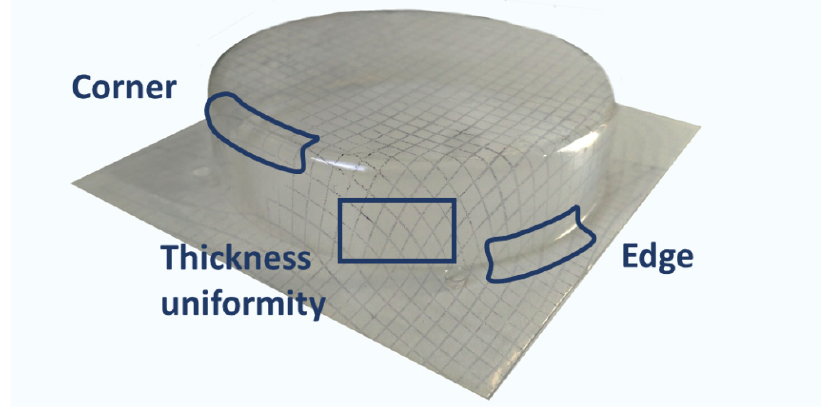
Figure 3. Picture of a thermoformed specimen. It shows the areas that are examined in order to evaluate the quality of the thermoforming.